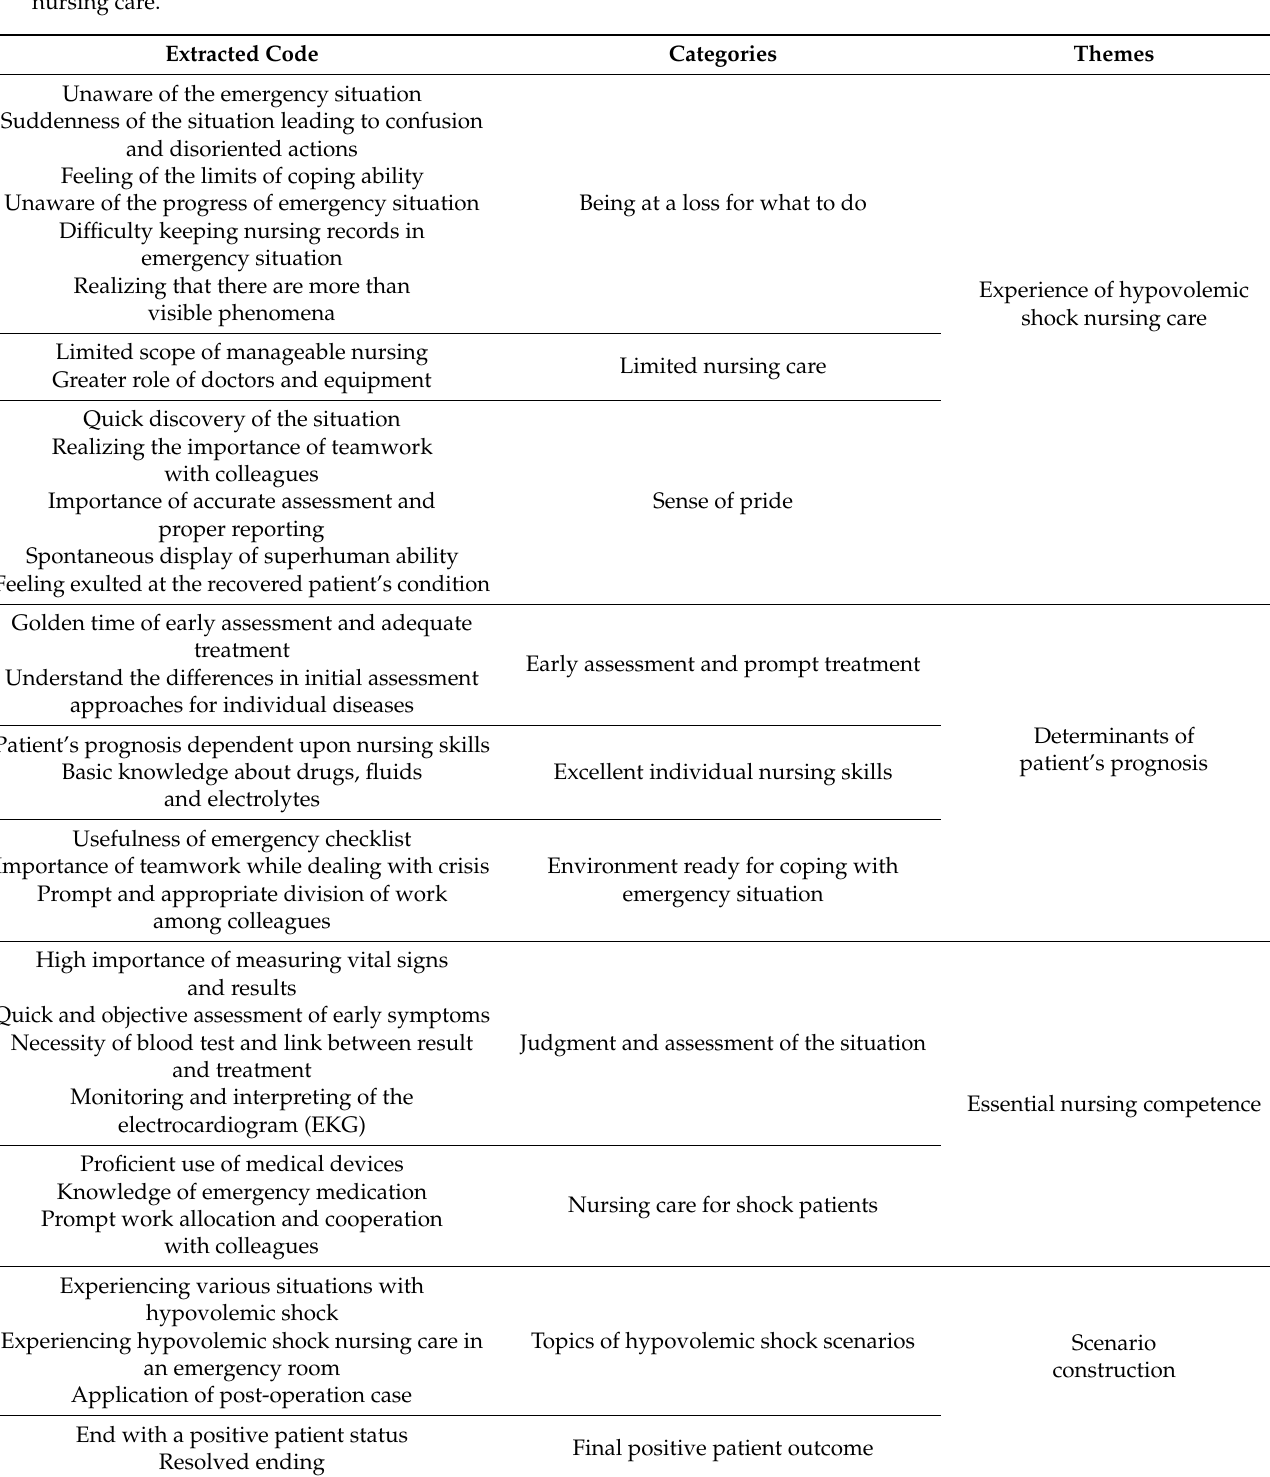
Table 4. Results of the content analysis to develop a virtual reality (VR) based simulation program for hypovolemic shock nursing